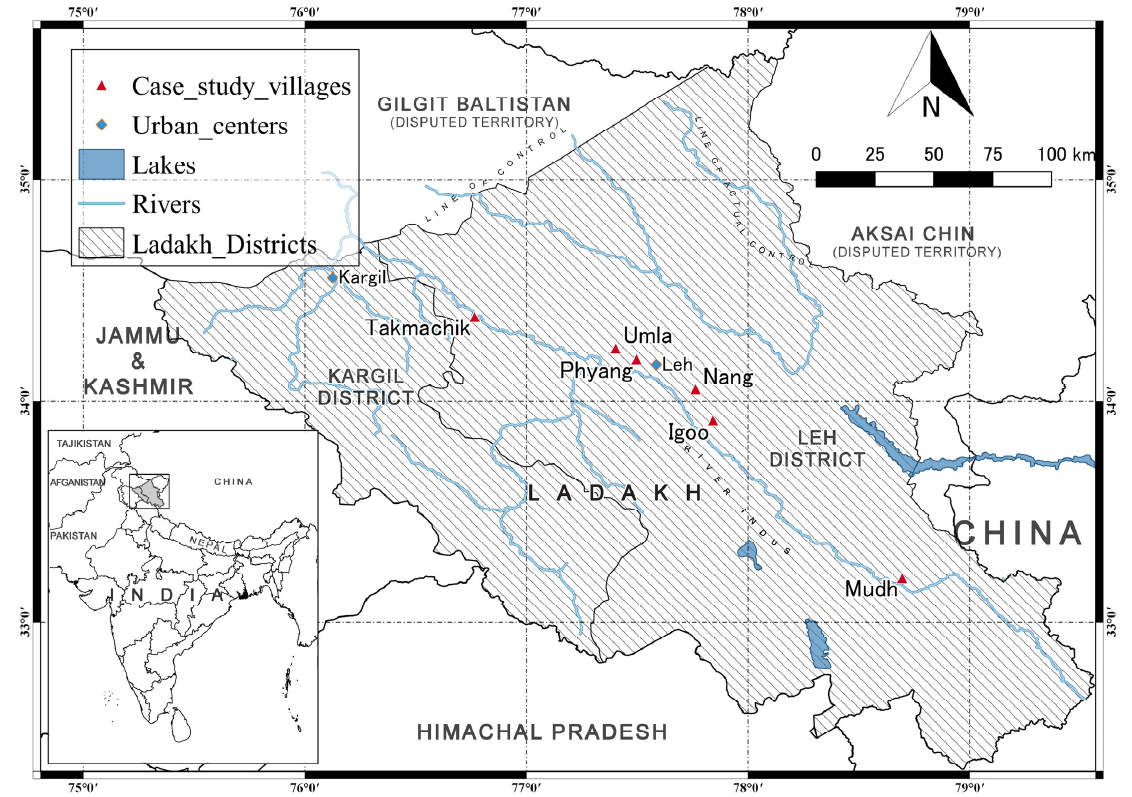
Figure 2. Location map of Ladakh with the case study villages.